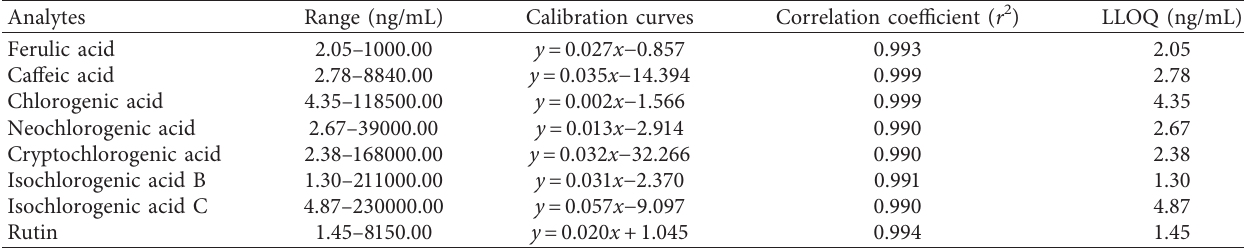
Table 2: The regression equations, linear range, and LLOQs of the 8 analytes.